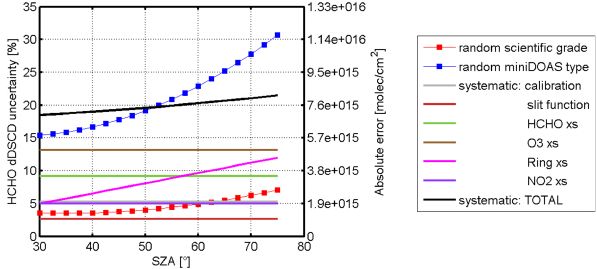
Fig. 18. Summary assessment of the error budget on HCHO dDSCD at 4 ◦ elevation, as a function of the SZA. Random uncertainties are typical of low-noise scientific grade instruments (red dots) and of mini-DOAS types of instruments (blue dots) for a typical integra- tion exposure time of